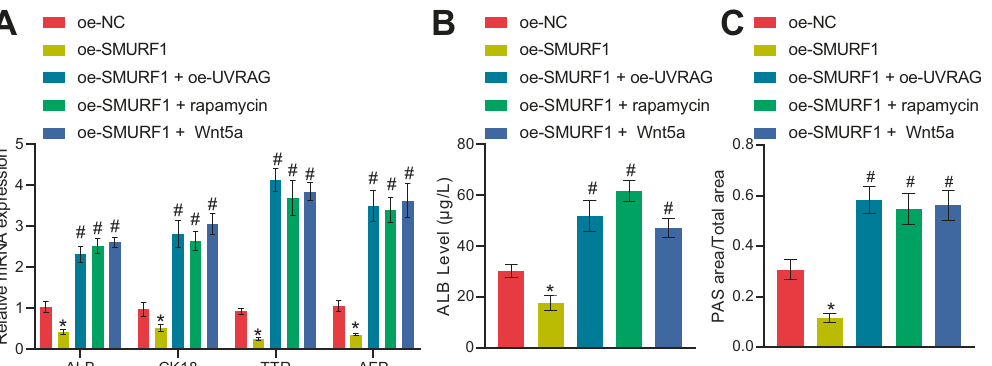
Fig. 9 SMURF1/UVRAG/ATG5/Wnt5a axis affects cirrhosis in mice. A RT-qPCR to detect the expression of hepatocyte-related genes in BMSCs after simultaneous treatment of oe-SMURF1 and oe-UVRAG, rapamycin, or recombinant Wnt5a for 14 days. B ELISA to detect the secretion of ALB by BMSCs after simultaneous treatment of oe-SMURF1 and oe-UVRAG, rapamycin, or recombinant Wnt5a for 14 days. C PAS staining of glycogen accumulation in BMSCs after simultaneous treatment of oe-SMURF1 and oe-UVRAG, rapamycin, or recombinant Wnt5a for 14 days. * p < 0.05 vs . BMSCs transfected with oe-NC; # p < 0.05 vs . BMSCs transfected with oe-SMURF1. The cell experiments were repeated three times.